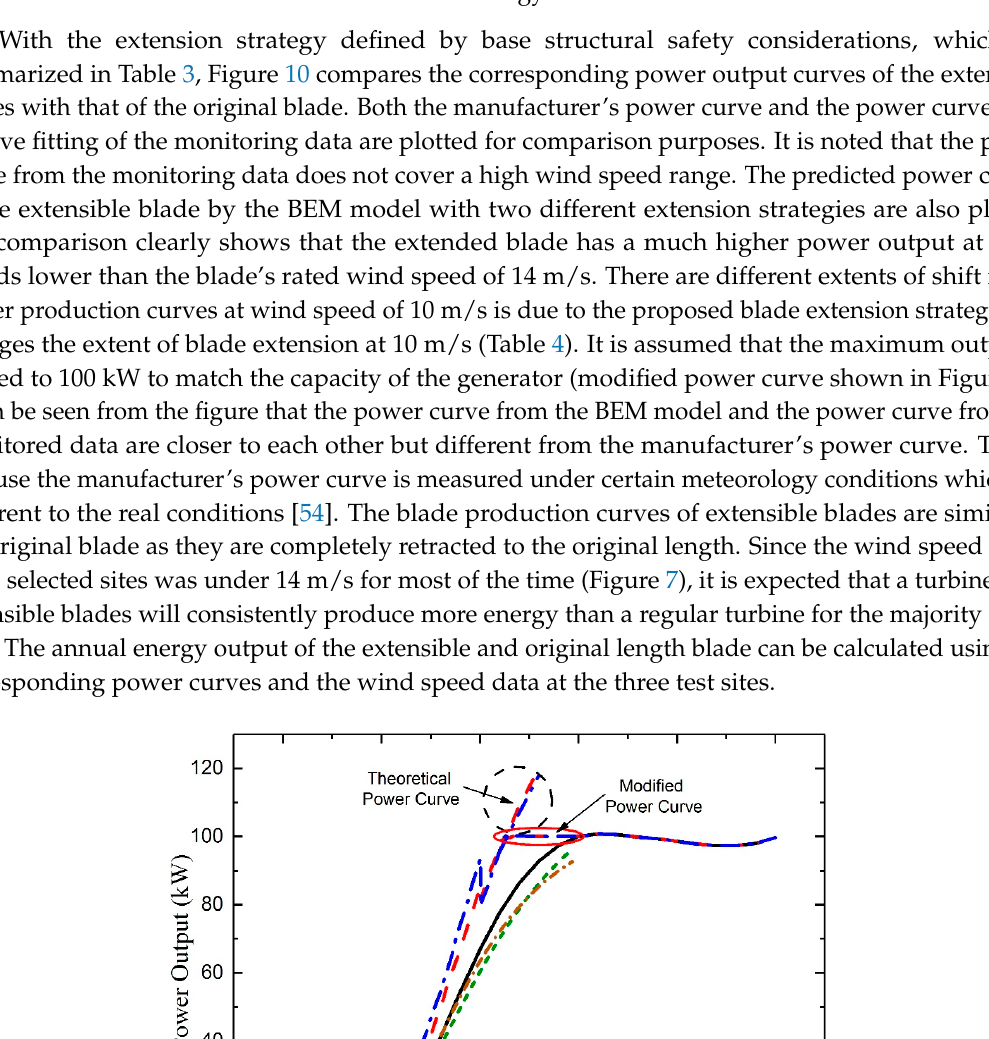
Figure 9. The shapes of first four modes for ( a ) original length blade; ( b ) blade-extension of 20% at the tip; ( c ) blade extension of 20% in the middle.